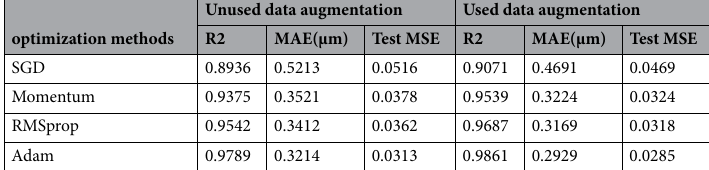
Table 4. Experimental results of different optimization